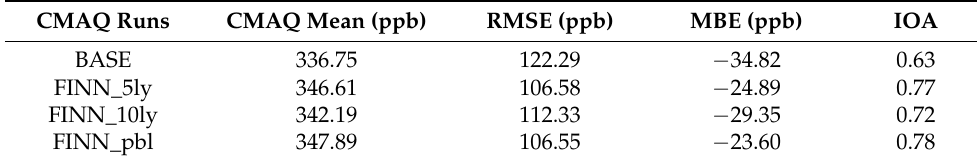
Table 2. Statistical verification between observed CO concentrations and results of CMAQ numerical simulations (BASE, FINN_5ly, FINN_10ly, FINN_pbl) at point AD from 20 to 30 April 2020.